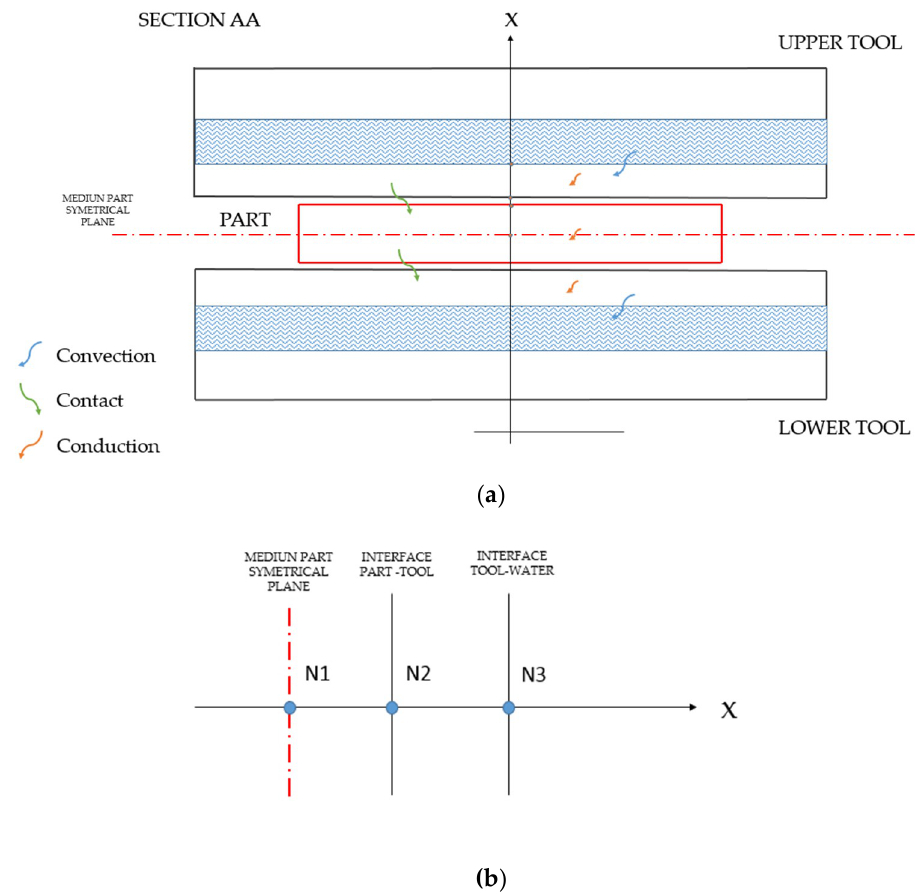
Figure 3. ( a ) Heat transfer model for a hot stamping tool. ( b ) Nodes for one-dimensional heat transfer model, with Node 1 (N1), Node 2 (N2), and Node 3 (N3). model, with Node 1 (N1), Node 2 (N2), and Node 3